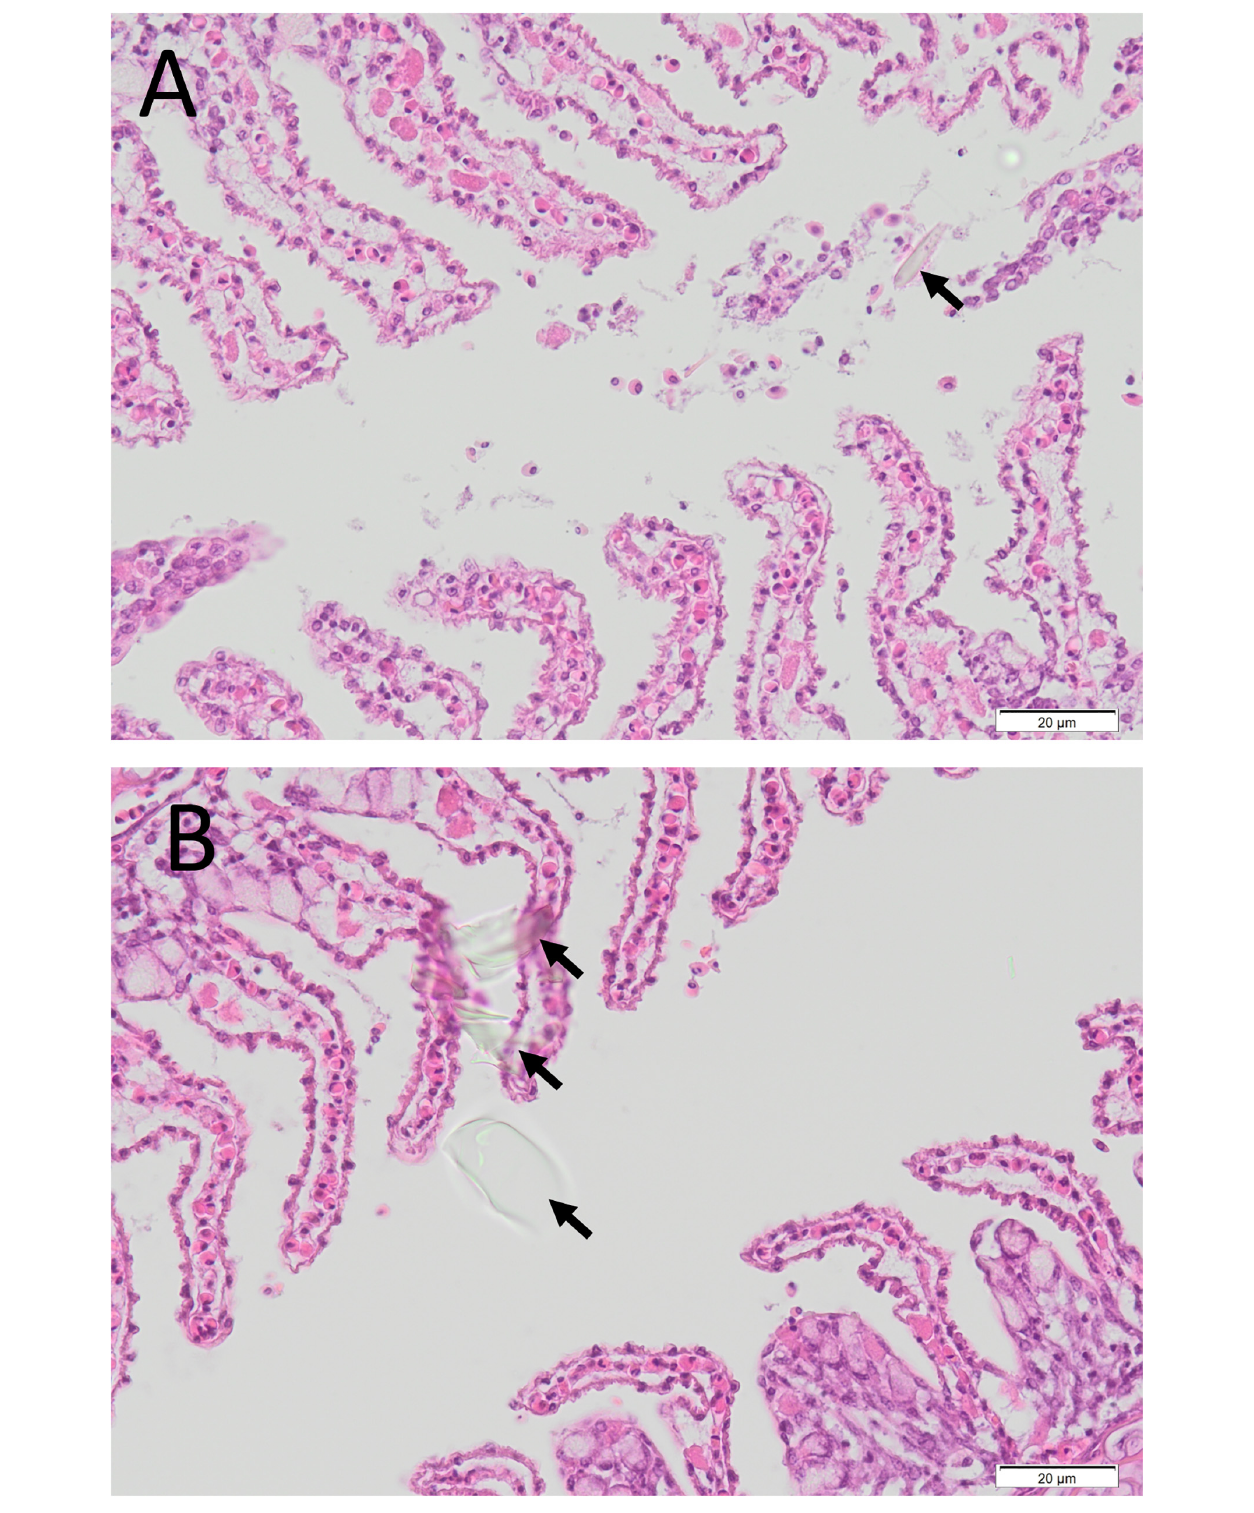
FIGURE 8 | Histological photomicrographs of the gill of an Ornate Cowfish ( Aracana ornate ) with diffuse epithelial hyperplasia and presence of cellular debris, including refractile diatom-like material (arrow), in the lamellar spaces (A) , and similar extraneous debris in the lamellar space and over the surface of the gill epithelium (arrows) (B) (40 × mag.) collected on 3/04/2013.